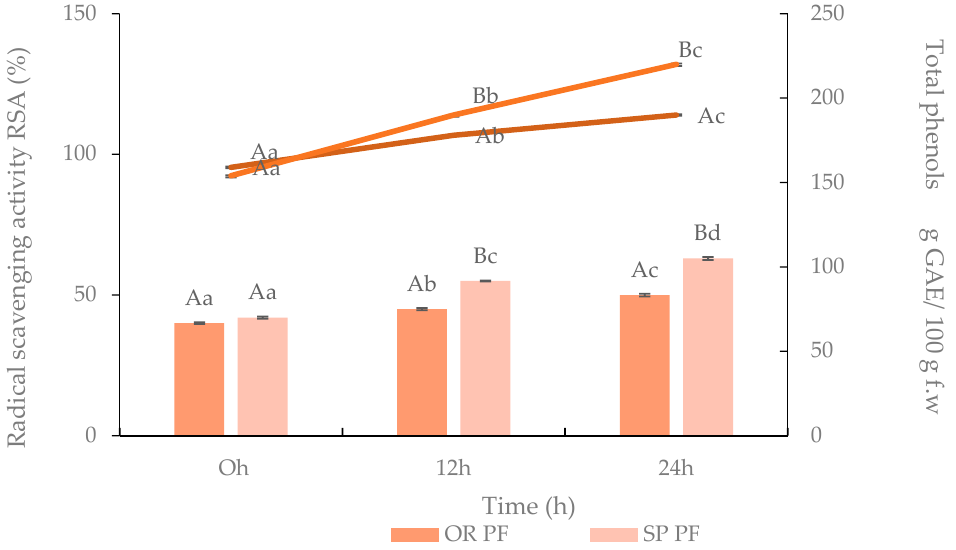
Figure 10. Total phenols and radical scavenging activity of gluten free muffins. Small letters in common indicate no significant differences between OR and SP samples withdrawn at different moments; Big different letters indicate significant differences between SP and OR samples withdrawn at the same moment.